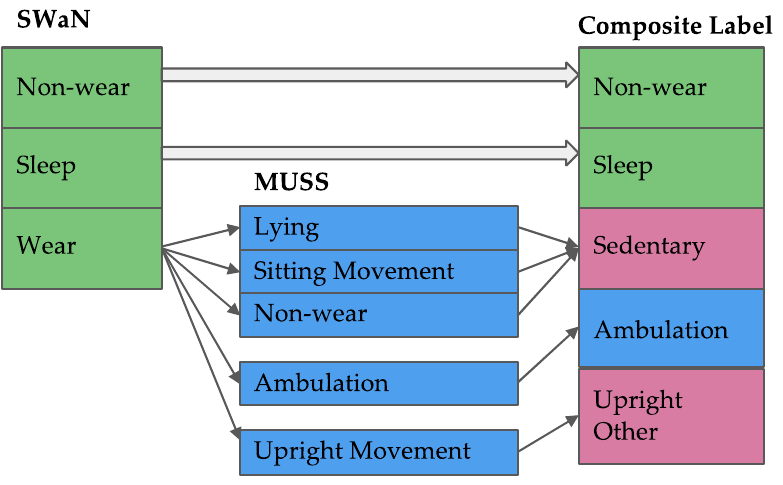
Figure 3. SWaN and MUSS algorithm output merging scheme for generating composite prediction labels. Algorithms outputs are first filtered by SWaN’s non-wear, sleep, and wear classifications. SWaN’s wear event classifications are assigned corresponding to MUSS classifications with lying, sitting movement, and non-wear, which are grouped under a composite “sedentary”